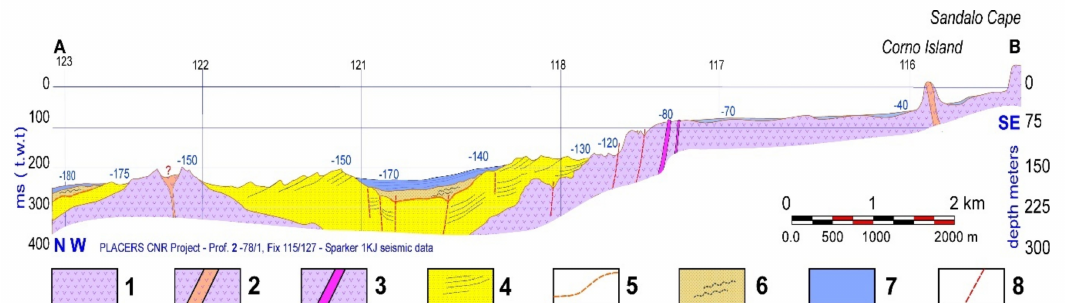
Figure 4. Geological section from seismic data of: Oceanography and Seabed—Mineral Resources—PLACERS Project CNR—Profilo 2-78/1, Fix 115/127—Sparker 1KJ: (1) Volcanites (Lower-Middle Miocene; (2) emission chimney; (3) dikes; (4) marine sedimentary sequence with inclined reflectors (Middle-Upper Miocene; (5) Messinian erosional surface; (6) marine sedimentary sequence with undulated reflectors. (Pliocene-Pleistocene); (7) Holocene-current drape; (8)